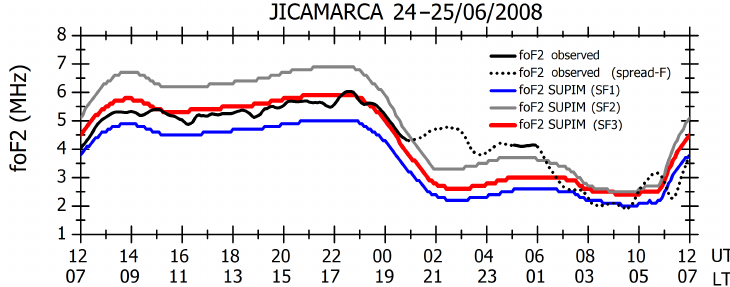
Figure 7. Comparison of critical frequency of the F layer ( fo F2) registered by the digisonde at Jicamarca (black solid curve) and the fo F2 modeled by SUPIM-INPE using different adjustments in the solar irradiance model (SOLAR2000). The dotted segment of the black curve indicates the fo F2 parameter processed in the presence of spread-F